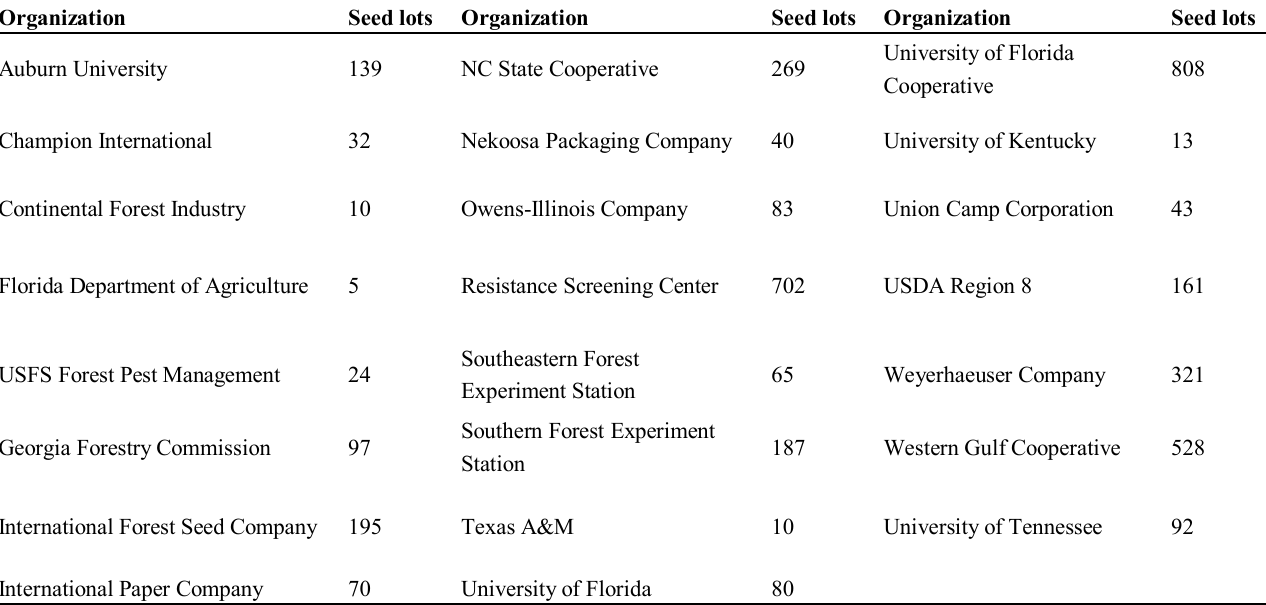
Table 2. The 1993 Annual Status Report of the RSC shows the diversity and extent of interest by several different kinds of organizations during 1986 through